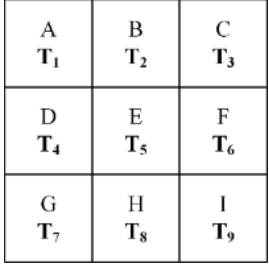
Figure 5. Tasks and files in a Moore neighborhood algorithm.